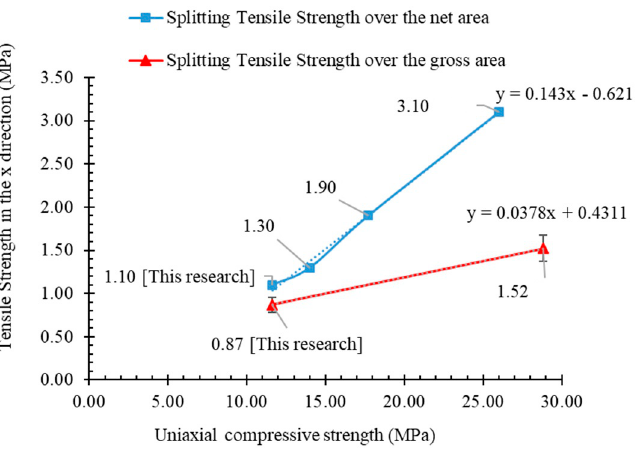
Figure 7. Summary of the experimental results reported in the specialized literature.